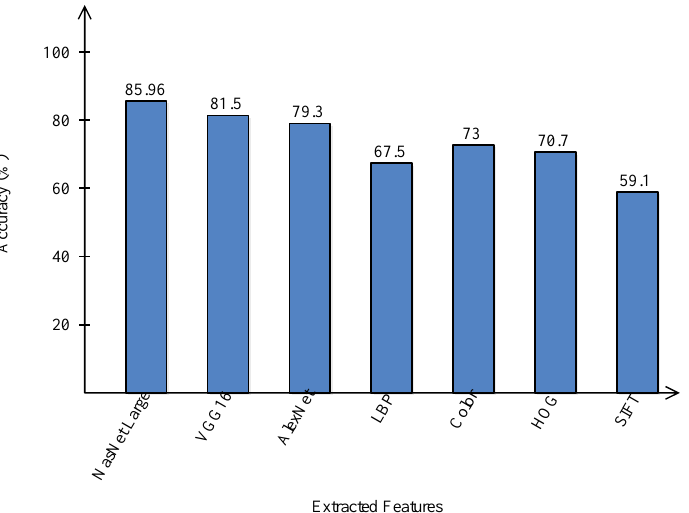
Figure 14. Comparison of deep learning and traditional features in terms of accuracy on ISIC2018 dataset.